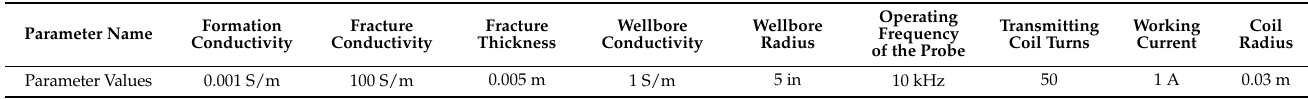
Table 2. Forward modeling parameter table.